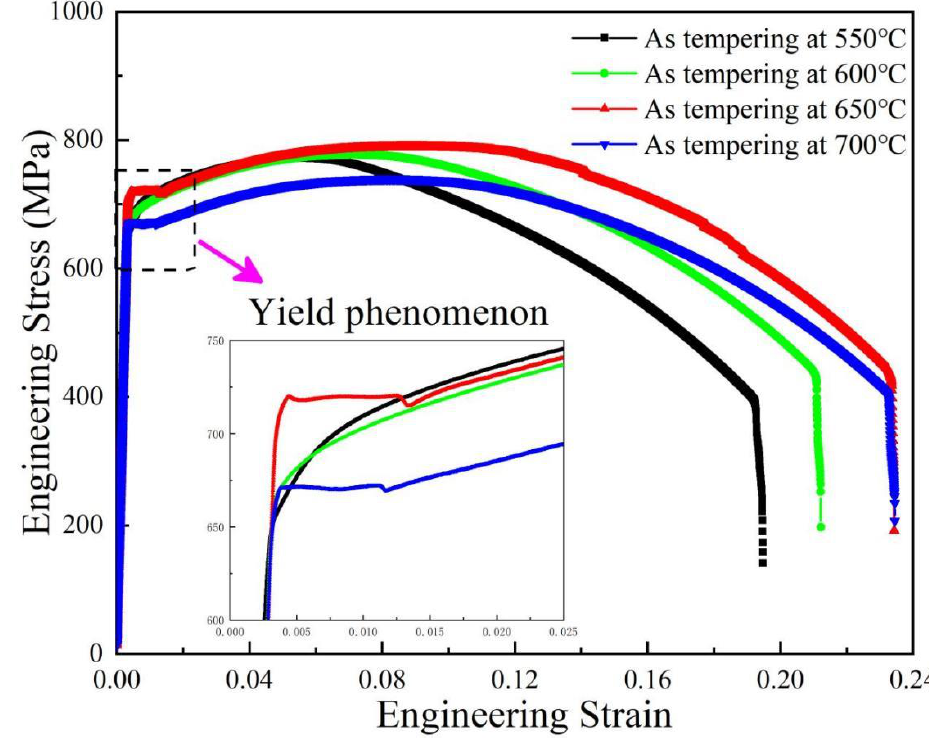
Figure 10. Tensile stress – strain curves after tempering at different temperatures.